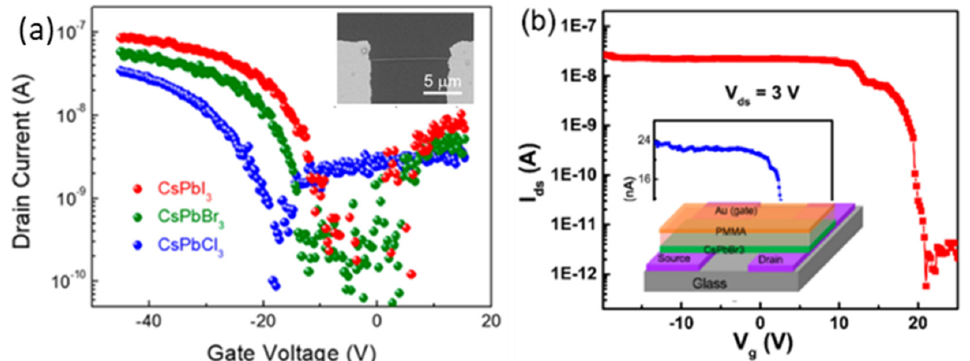
Figure 8. ( a ) Transfer characteristics of the typical single VLS − grown CsPbX 3 (X = Cl, Br or I) NW FETs using logarithm y-coordinate. Inset shows the SEM image of the as-fabricated NW PD ( b ) Semilog CsPbBr 3 plot of the gate transfer characteristic Ids-Vg measured at Vds = 3.0 V and swipe rate 1.1 V/s. Inset shows the same plot in linear scale. Reproduced with permission from [166]. Copyright 2020, American Chemical Society.